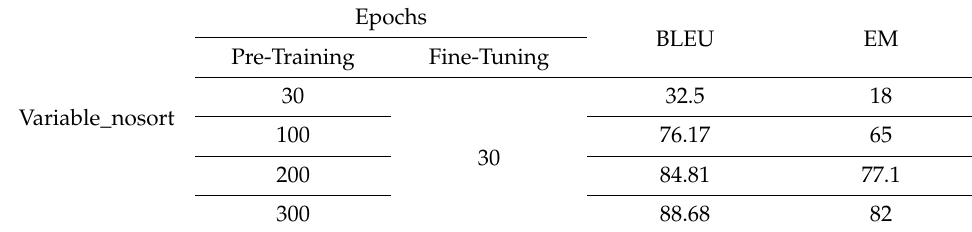
Table 13. Result of improvement by pre-training from the